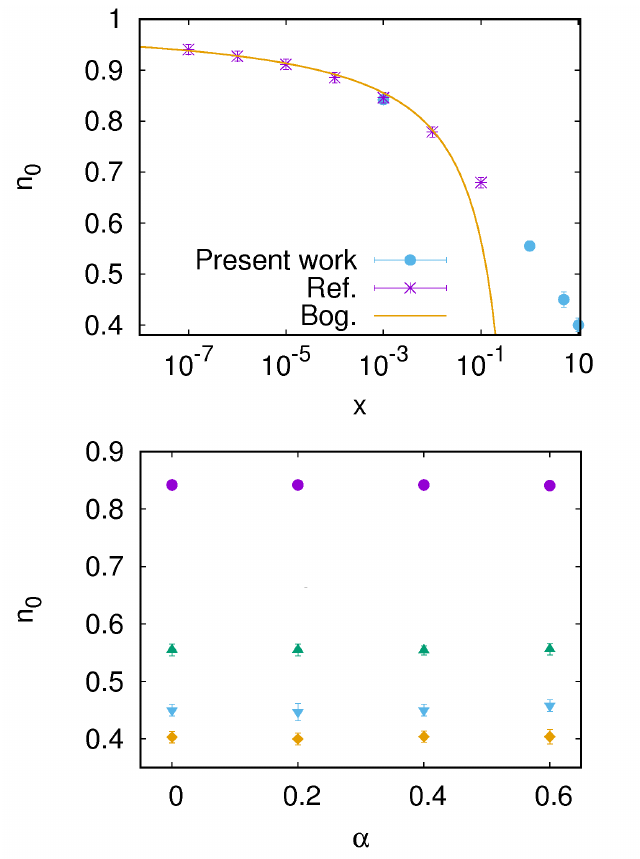
Figure 5: Condensate fraction as a function of the gas parameter (upper plot), and as a function of α for different gas parameters x = 0.001 (dots), 1 (up-triangles), 5 (down-triangles), and 10 (diamonds) (lower plot). In the upper plot, we provide the values obtained by Ref. [ 42 ] , as well as the Bogoliubov prediction, which is plotted for x <